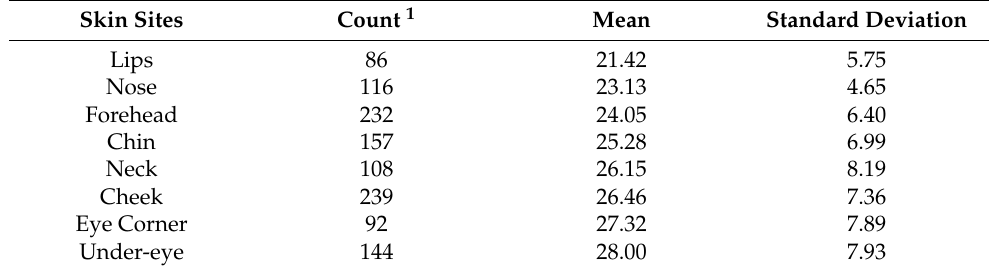
Table 1. The measured skin Epsilon values of different volunteers at the different skin sites. Epsilon values are in AU (arbitrary units, proportional to water